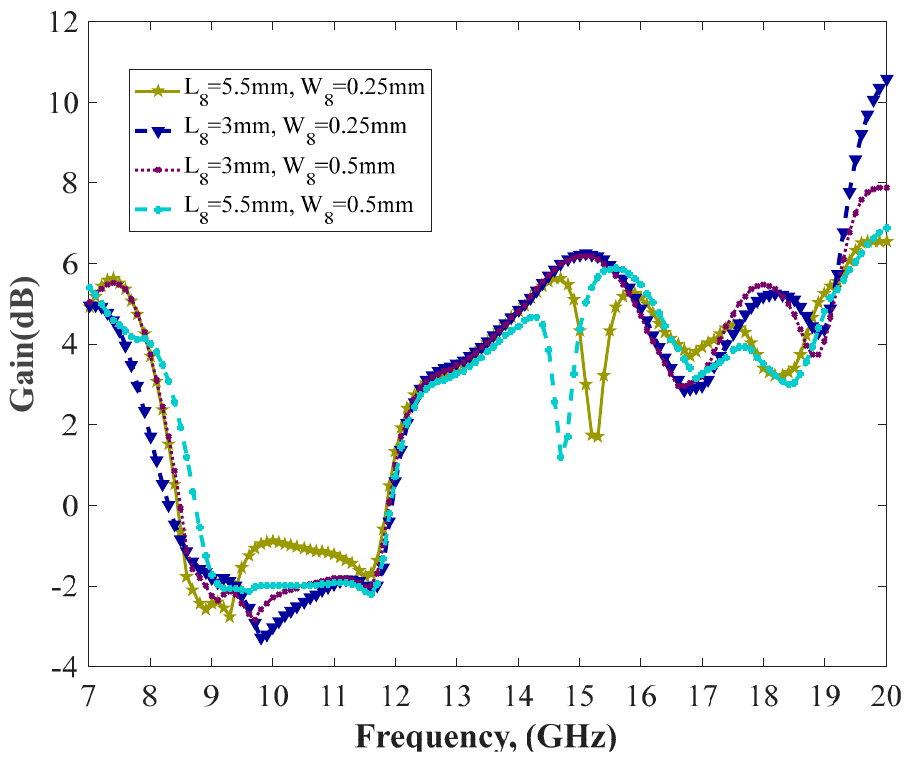
Figure 6. The gain of the proposed slotted-patch antenna as the length and the width of the slots are changed.